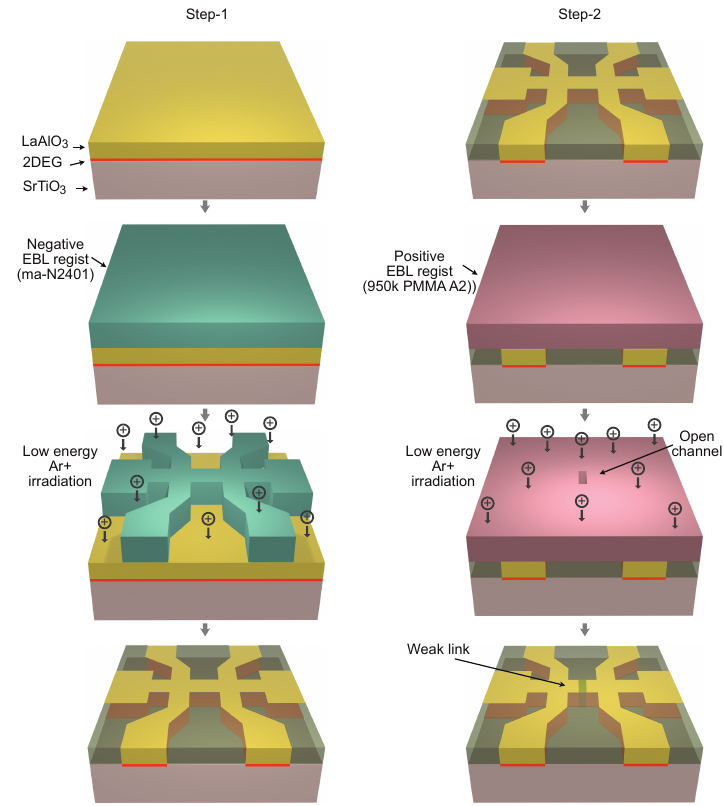
Figure 1. Two-step fabrication process for weak links in the LAO/STO interface. In the first step, narrow channels are created by electron beam lithography and low-energy ion irradiation. In the second step, the weak links are created by low dose Ar + ion irradiation through a slit across the prefabricated channel using electron beam lithography and a positive e-beam